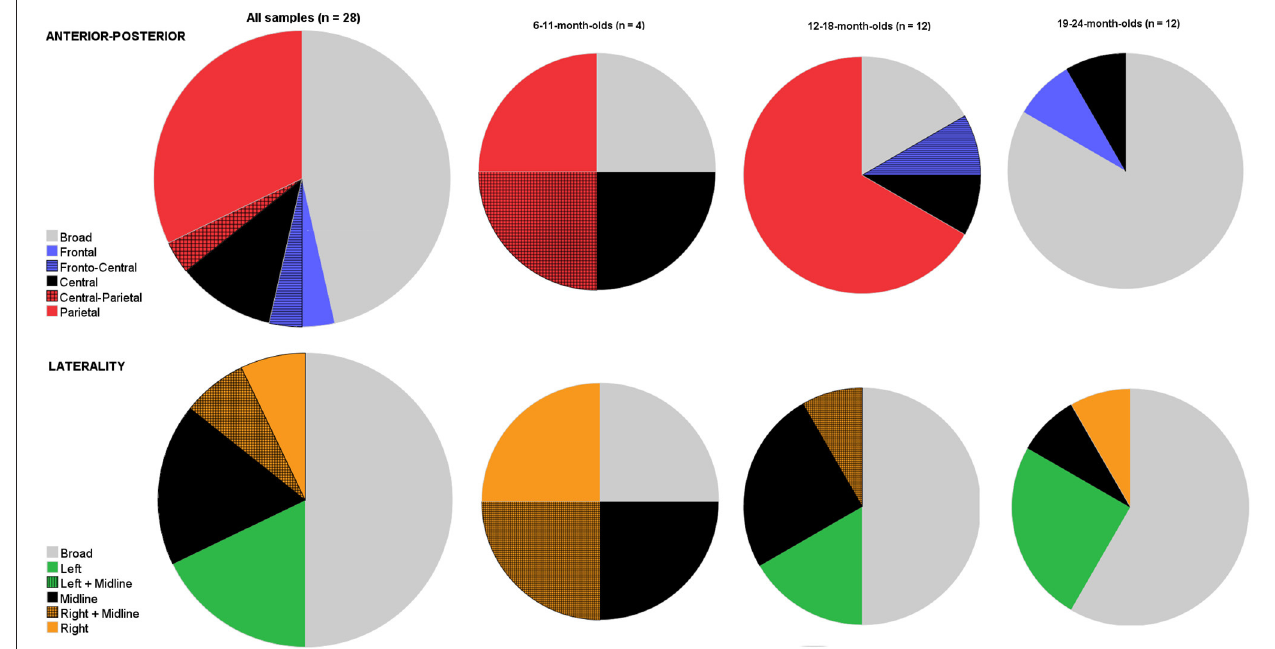
FIGURE 3 | Pie charts depicting the variation in studies on where on the scalp it is that the N400 priming effect is present (top row: anterior-posterior axis; bottom row: lateral axis) shown for all 28 visual object-word priming studies (age: 6–24-month-olds), and subdivided into three smaller age bins (6–11-month-olds; 12–18-month-olds; 19–24-month-olds). For both axes, there is also a broad category possible, indicating that there is no statistical evidence that the N400 is differently distributed across this